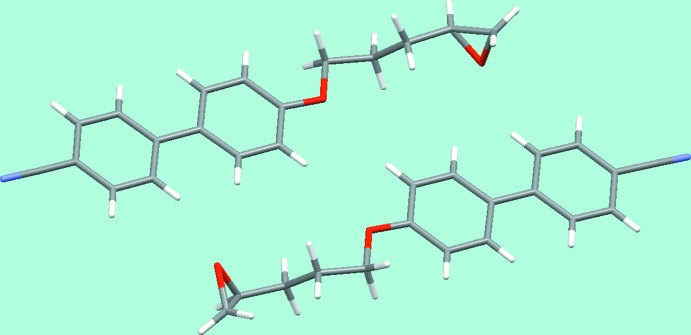
The asymmetric unit (two mol­ecules) of the oxirane.